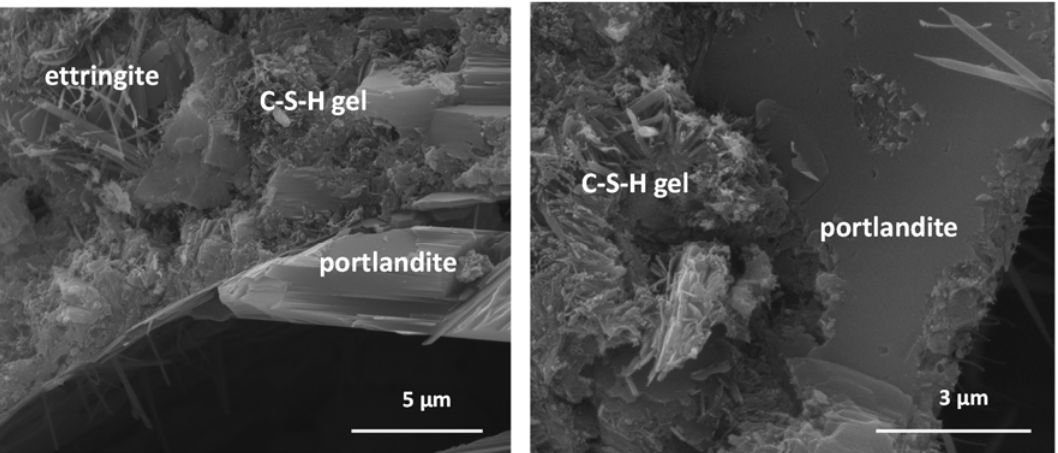
Figure 1. ( Left ) C-S-H gels, portlandite, and ettringite filling cracks. ( Right ) Detail of C-S-H gel fibres and portlandite formation on the gel.